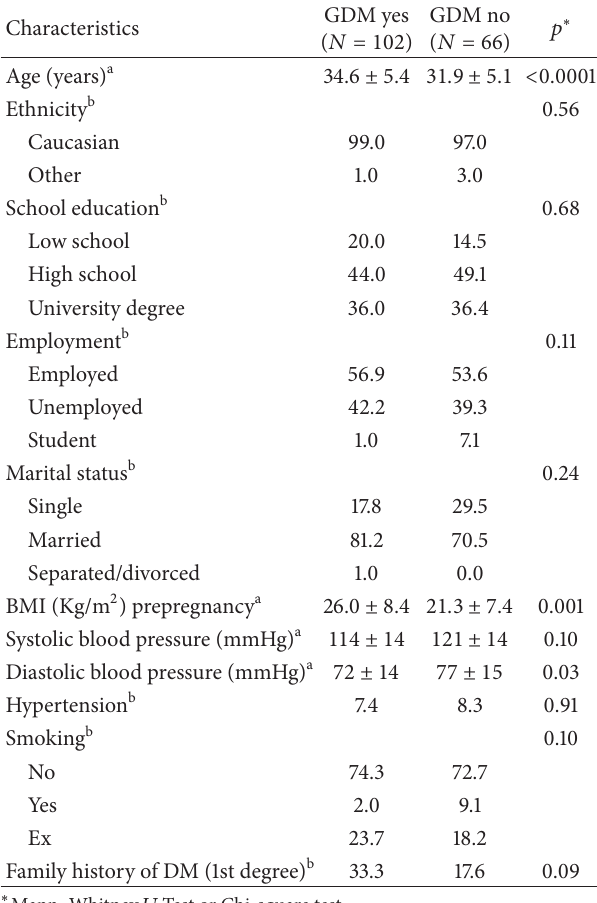
Table 1: Characteristics of cases and